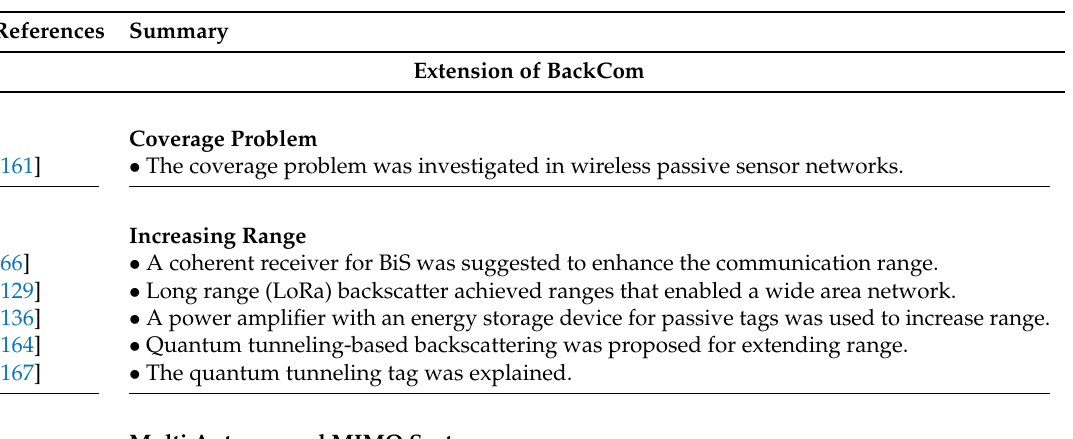
Table 11. Extension and reliability in